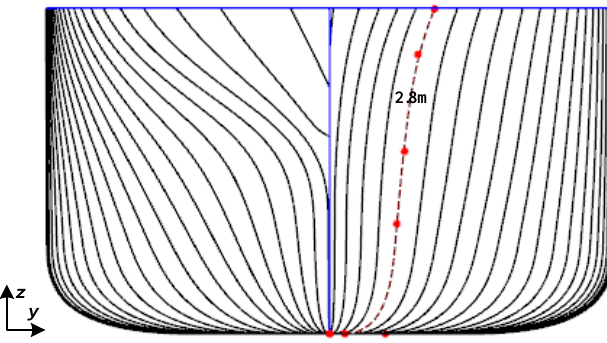
Figure 16. Series 60 cross-section curve diagram.